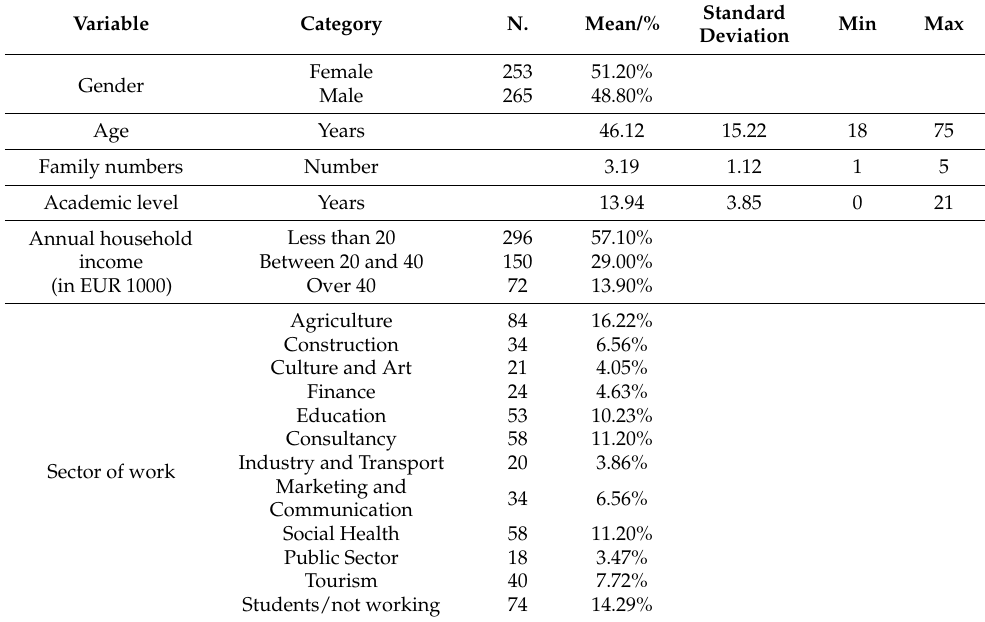
Table 6. Respondents’ socio-demographic and economic